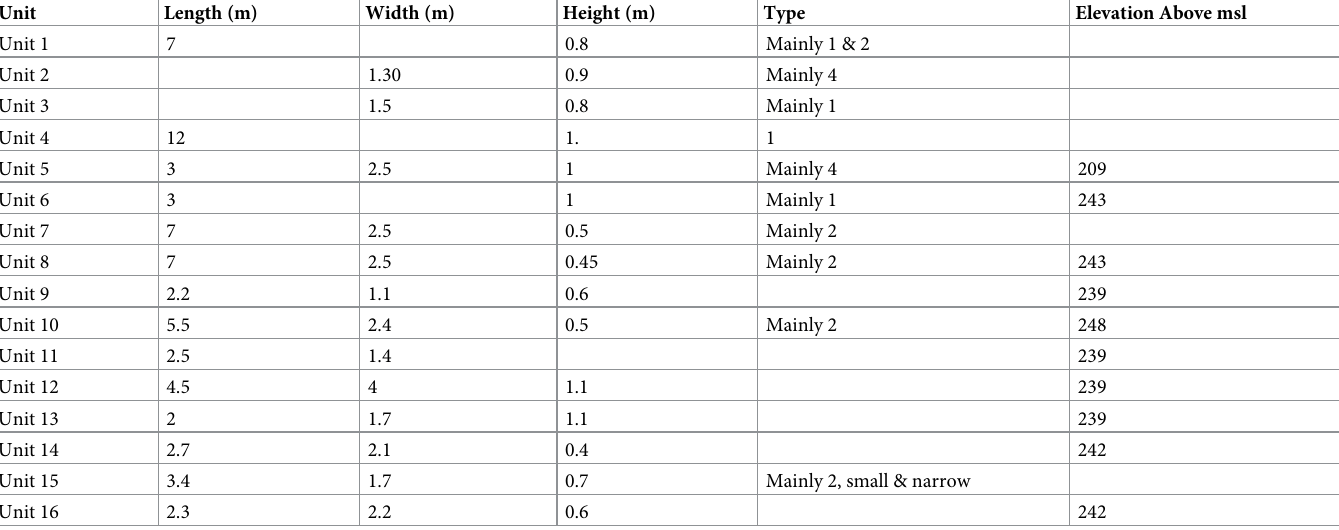
Table 2. Size and rock damage patterns of the 16 selected